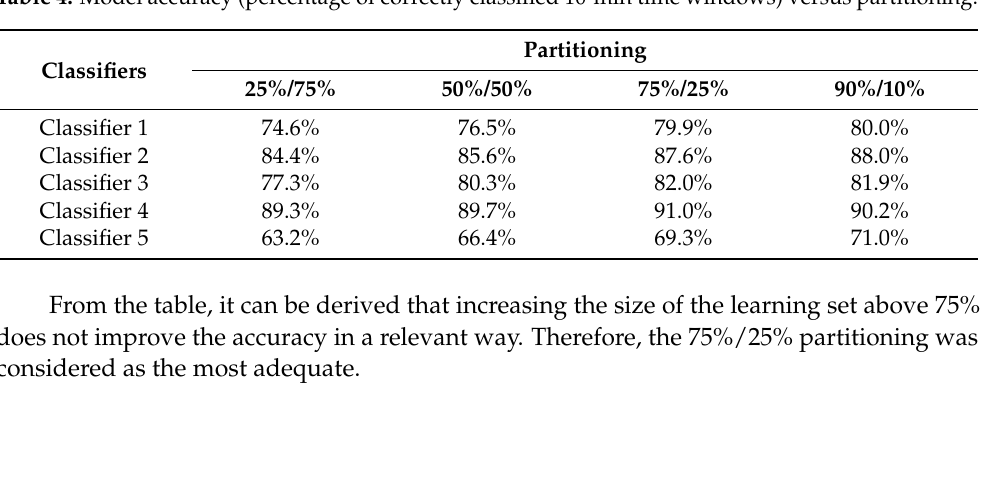
Table 4. Model accuracy (percentage of correctly classified 10-min time windows) versus